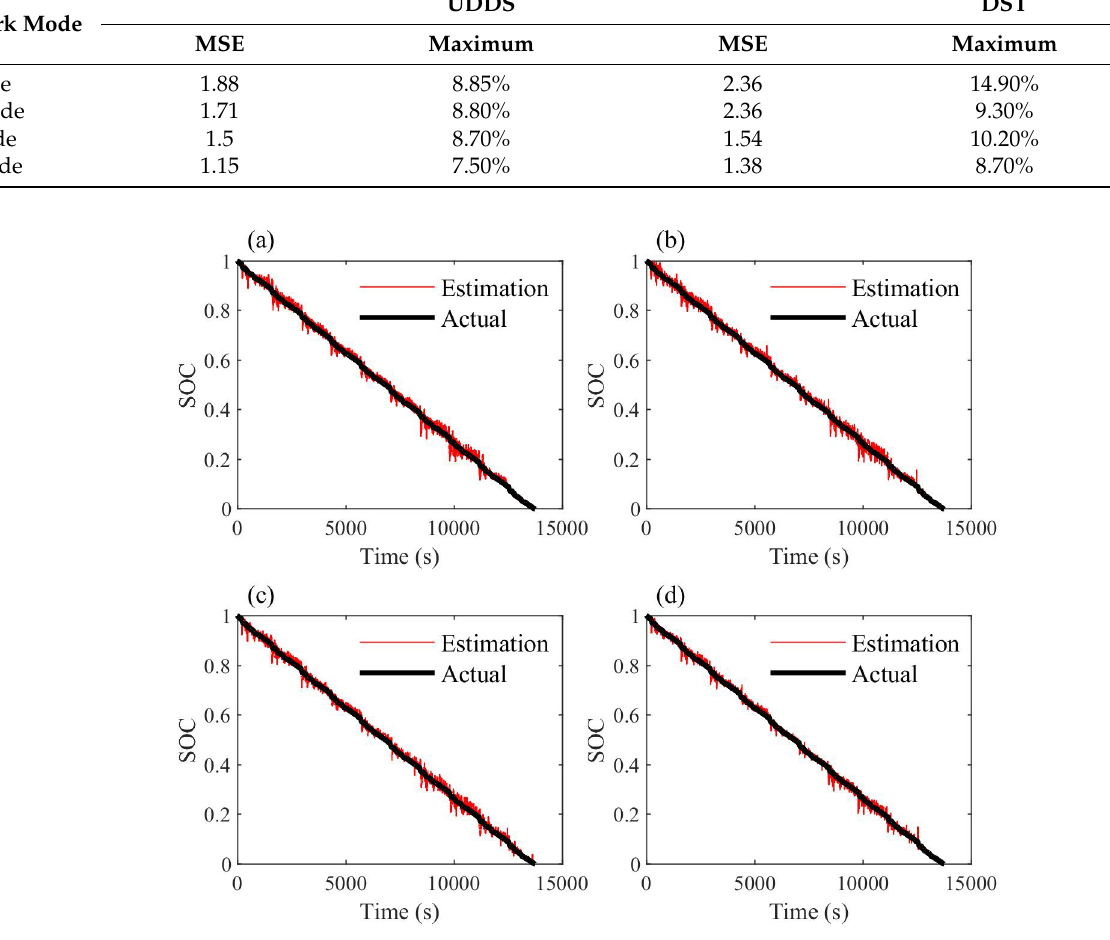
Figure 7. SOC estimation results for the UDDS profile in the four modes: ( a ) first mode, ( b ) second mode, ( c ) third mode, and ( d ) fourth